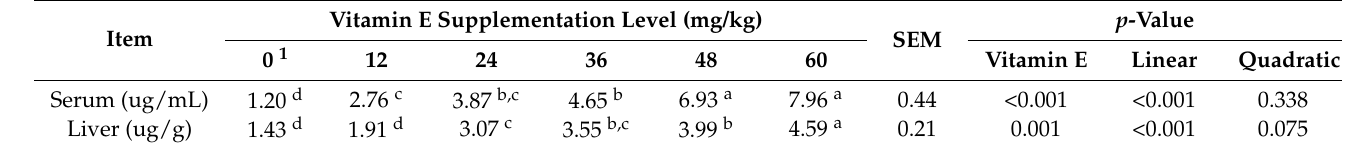
Table 2. Effect of dietary vitamin E supplementation on α -tocopherol content in the serum and liver of male Jiangnan white goslings on day 28.